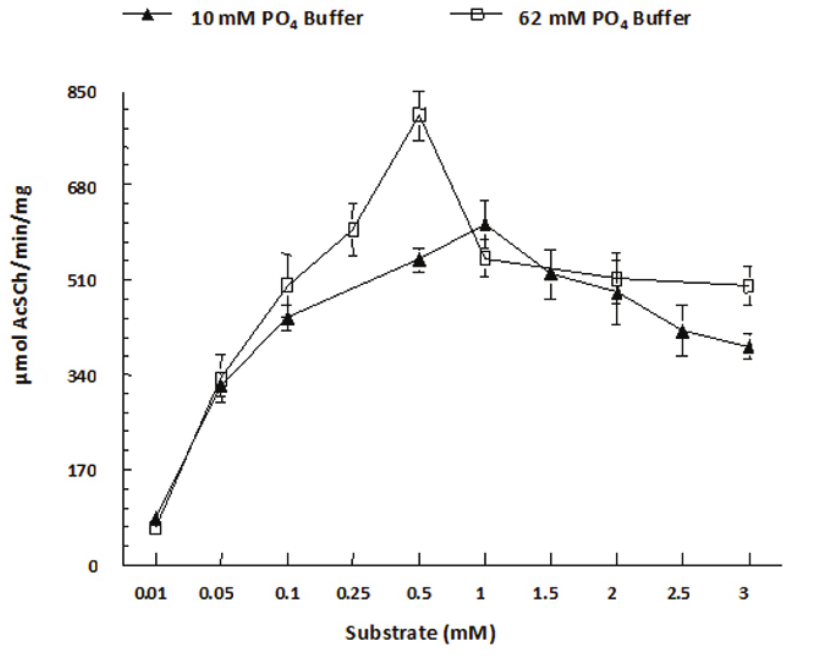
Figure 3. Reduction of enzyme substrate inhibition in high ionic strength buffer. Hydrolysis of , pH 7.5, buffer and 62 mM PO , pH 7.5, buffer by krait ( Bungaraus sindanus ) acetylthiocholine in 10 mM PO 4 4 , pH venom AChE. Reduction of substrate inhibition is clearly visible in high ionic strength buffer (62 mM PO 4 7.5). Venom AChE was incubated in the media for ten minutes at 37°C before addition of different substrate concentrations (0.05-3 mM). Results are the mean of four different experiments performed in